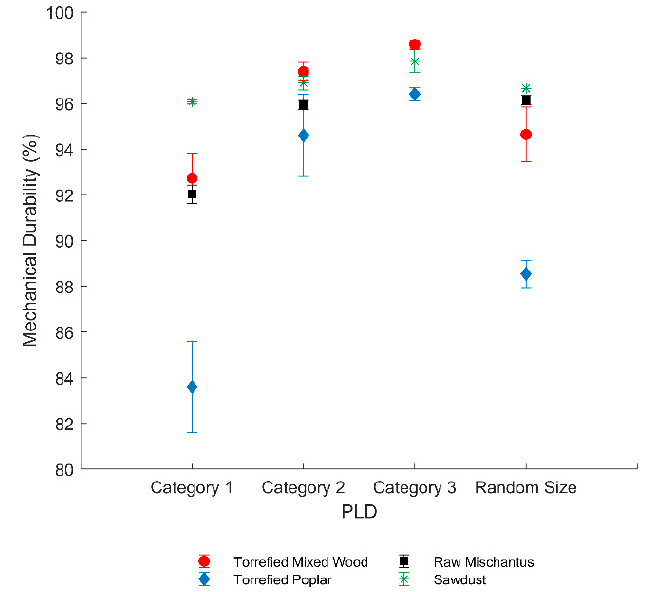
Figure 5. Mechanical durability results of different biomass pellets based on their pellet length distributions. Error bars show the standard deviation.